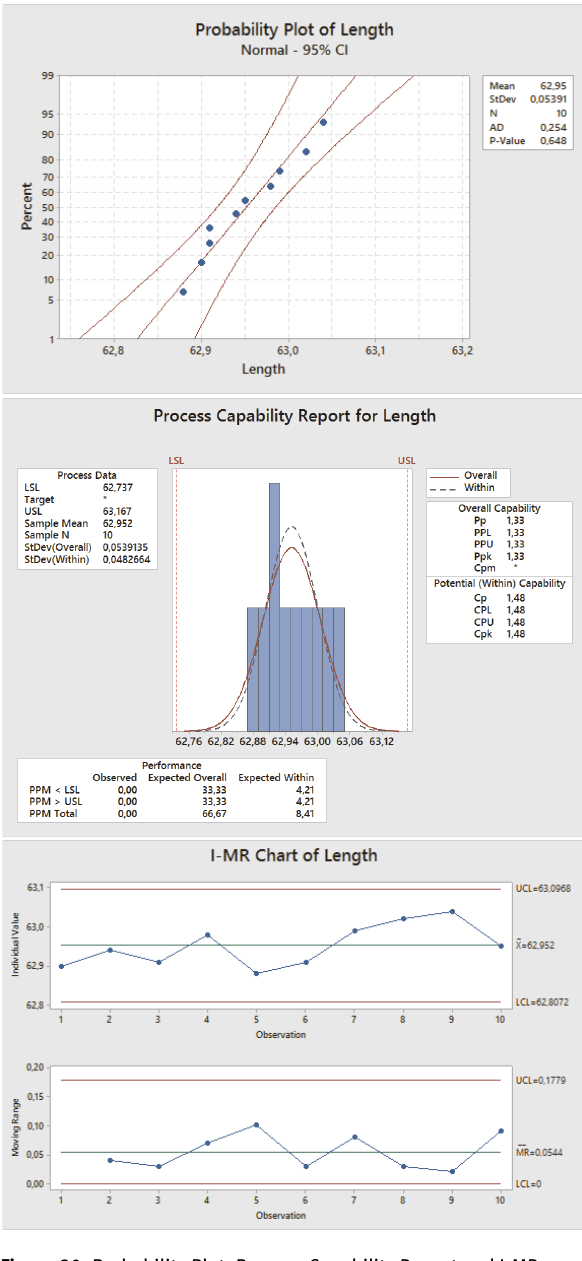
Figure 20: Probability Plot, Process Capability Report and I-MR Chart for the length of